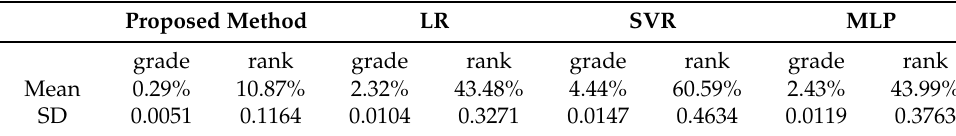
Table 7. Prediction Performances (MAPE) of Different Methods for 100